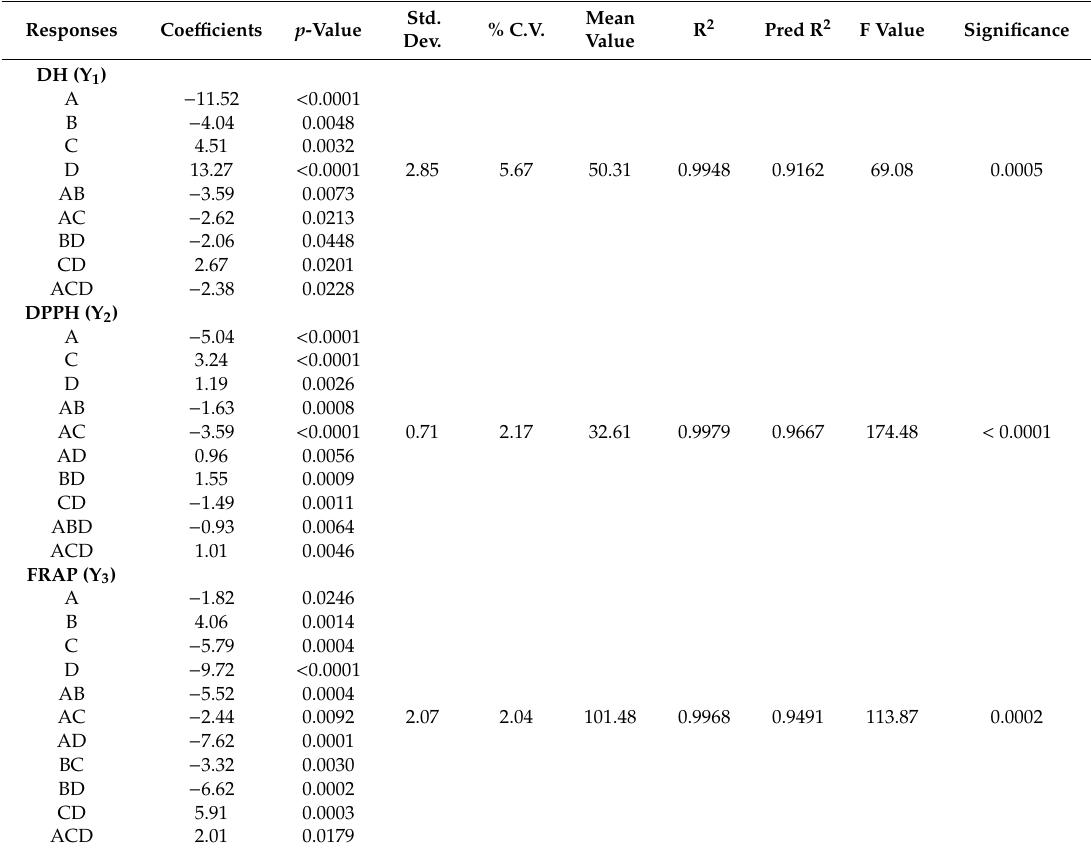
Table 3. Results of ANOVA for di ff erent responses. R 2 : coe ffi cient of